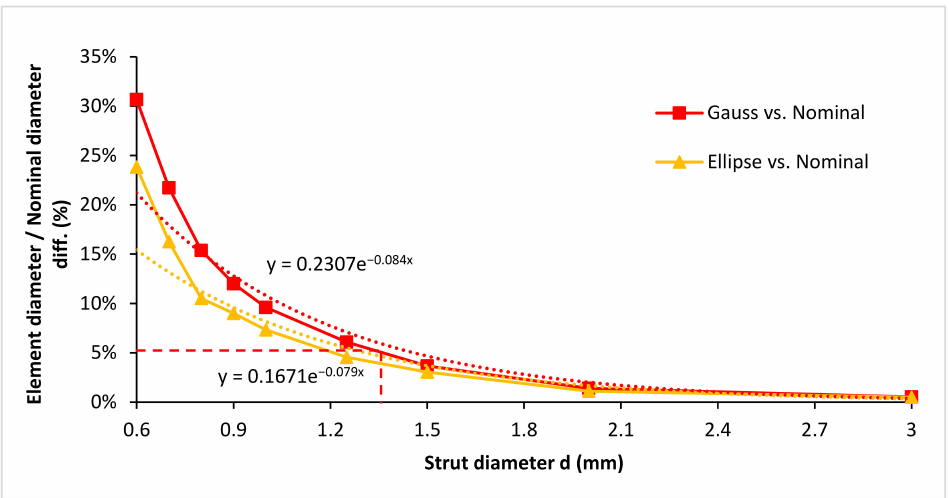
Figure 11. Graph of Gauss diameter and ellipse substitute diameter difference to the nominal